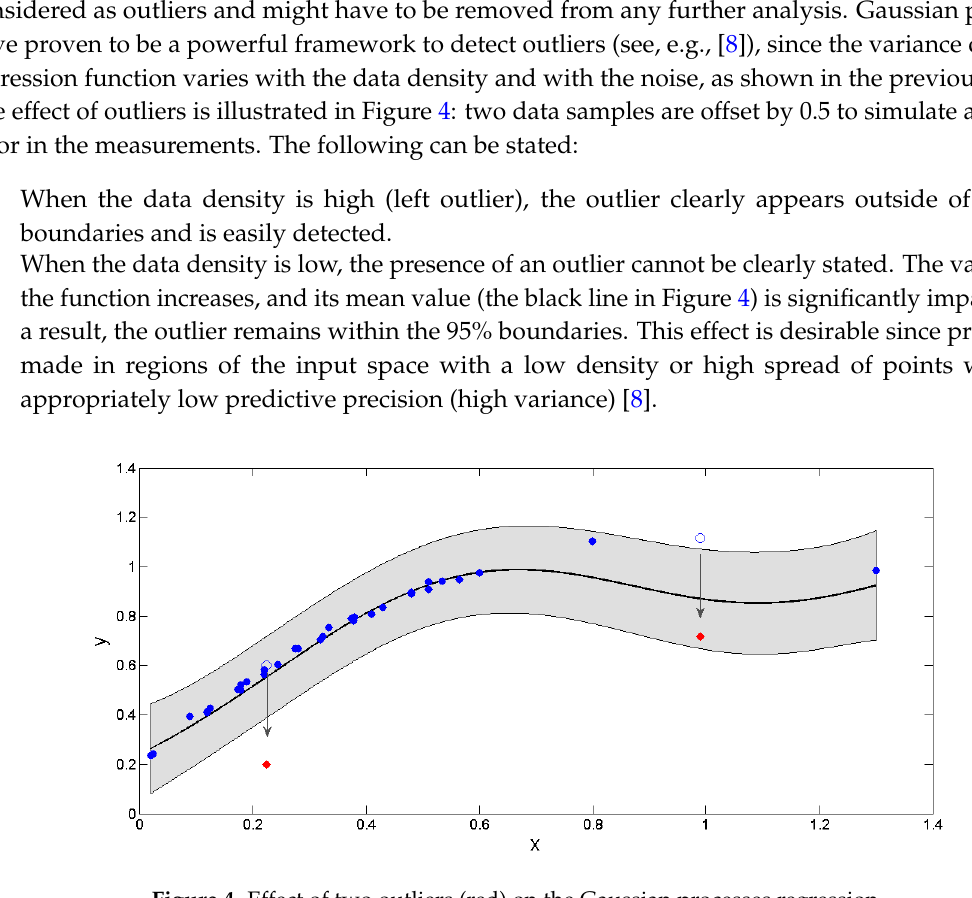
Figure 4. Effect of two outliers (red) on the Gaussian processes